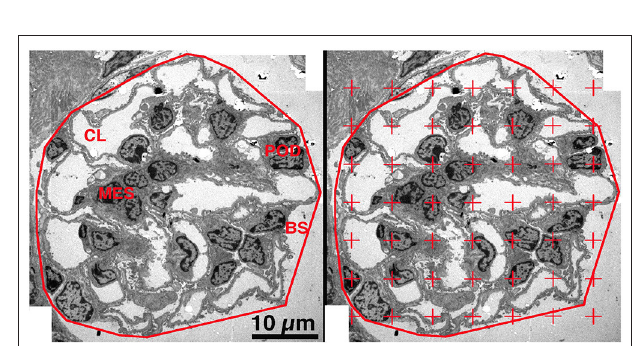
FIGURE 2 | Areal density of glomerular components. Left Panel . On a low magnification EM image the glomerulus was defined by drawing a minimum string polygon around the tuft. Four components were defined: podocyte (POD), mesangium (MES), capillary lumen (CL), and remainder which included Bowman’s space (BS) and GBM. Right Panel . A counting grid was randomly placed over the image and the number of points falling on each component is counted. The areal density of component X was calculated by dividing the number of grid points falling on component X by the total number of points falling on all four